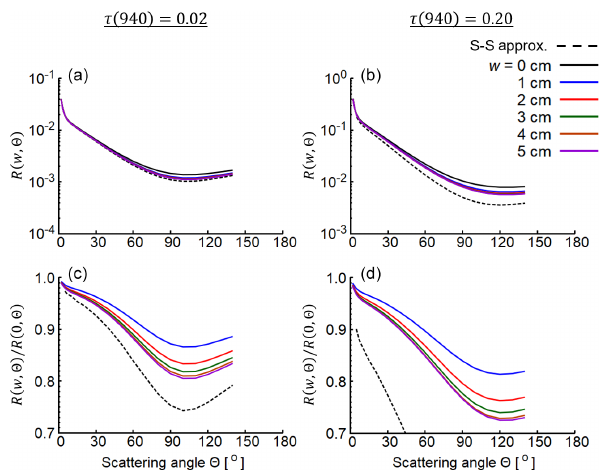
Figure 3. Normalized angular distributions simulated for continental-average aerosol (Table 2) in the almucantar plane with aerosol optical thicknesses of 0.02 and 0.20 at 940nm. Simulations were conducted for SZA = 70 ◦ and PWV (w) = 0, 1, 2, 3, 4, and 5cm. The top row is the normalized radiance R(w,(cid:50)) , and the bottom row is the ratio of R(w,(cid:50)) to R( 0 ,(cid:50)) . “S-S approx.” is the single-scattering approximation.